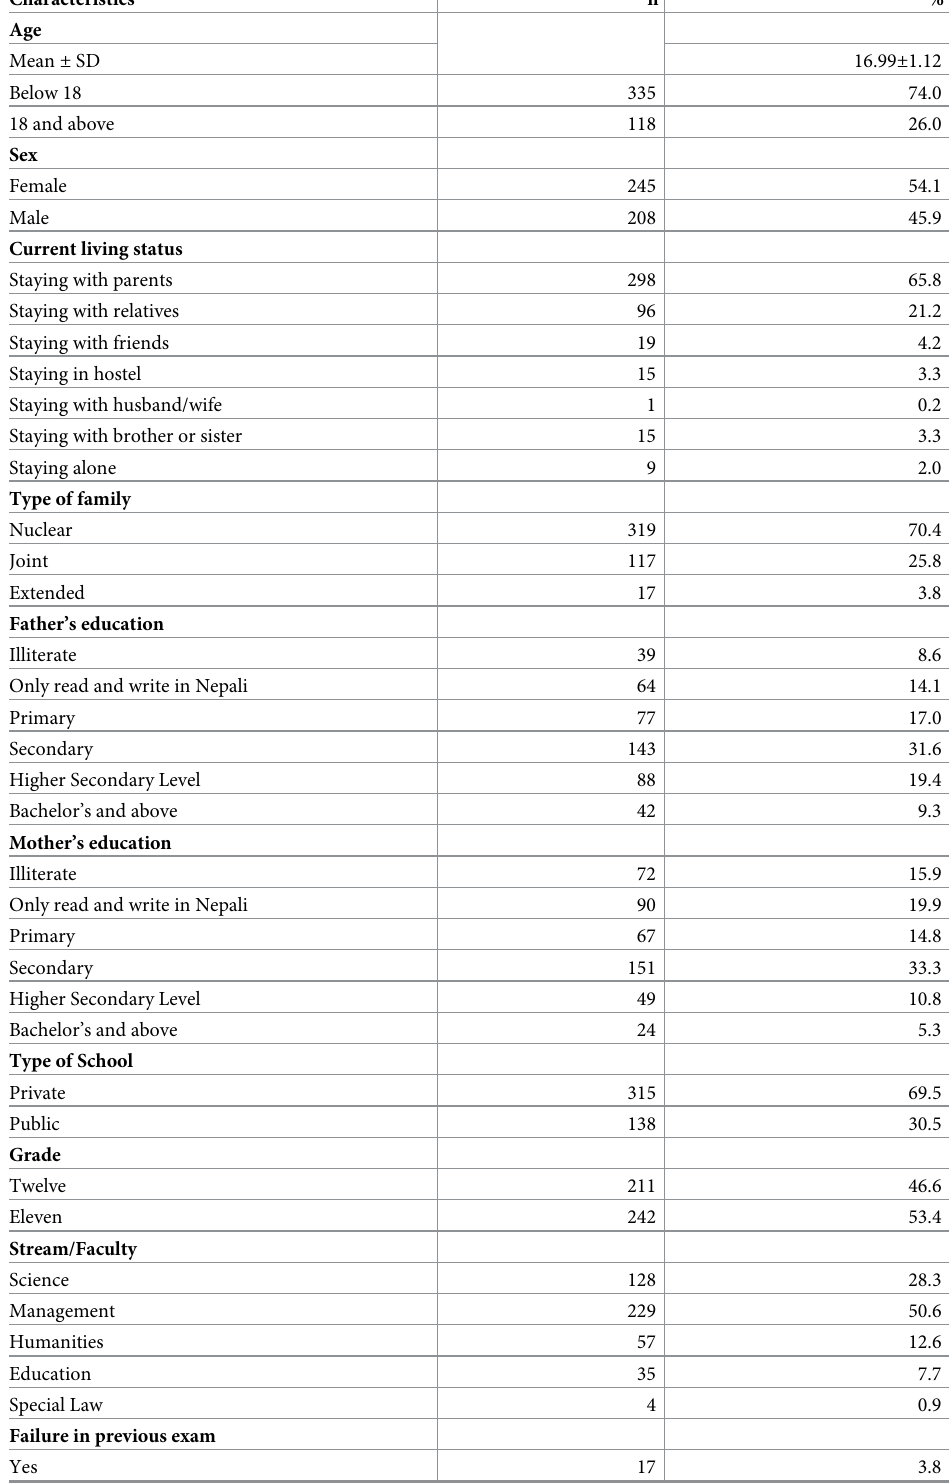
Table 2. Distribution of the students by socio-demographic, academic and contextual characteristics (n = 453).